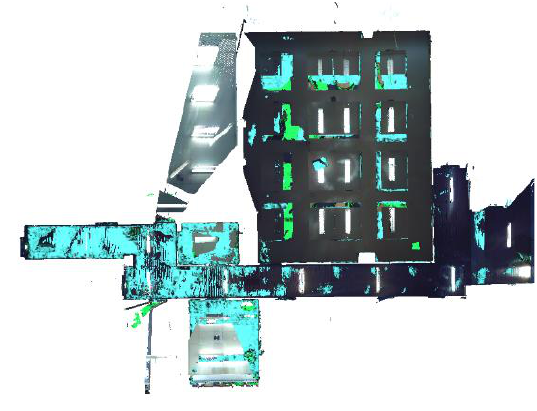
Figure 6. Hololens mesh (in cyan colour) registered with the terrestrial laser scanner point cloud.